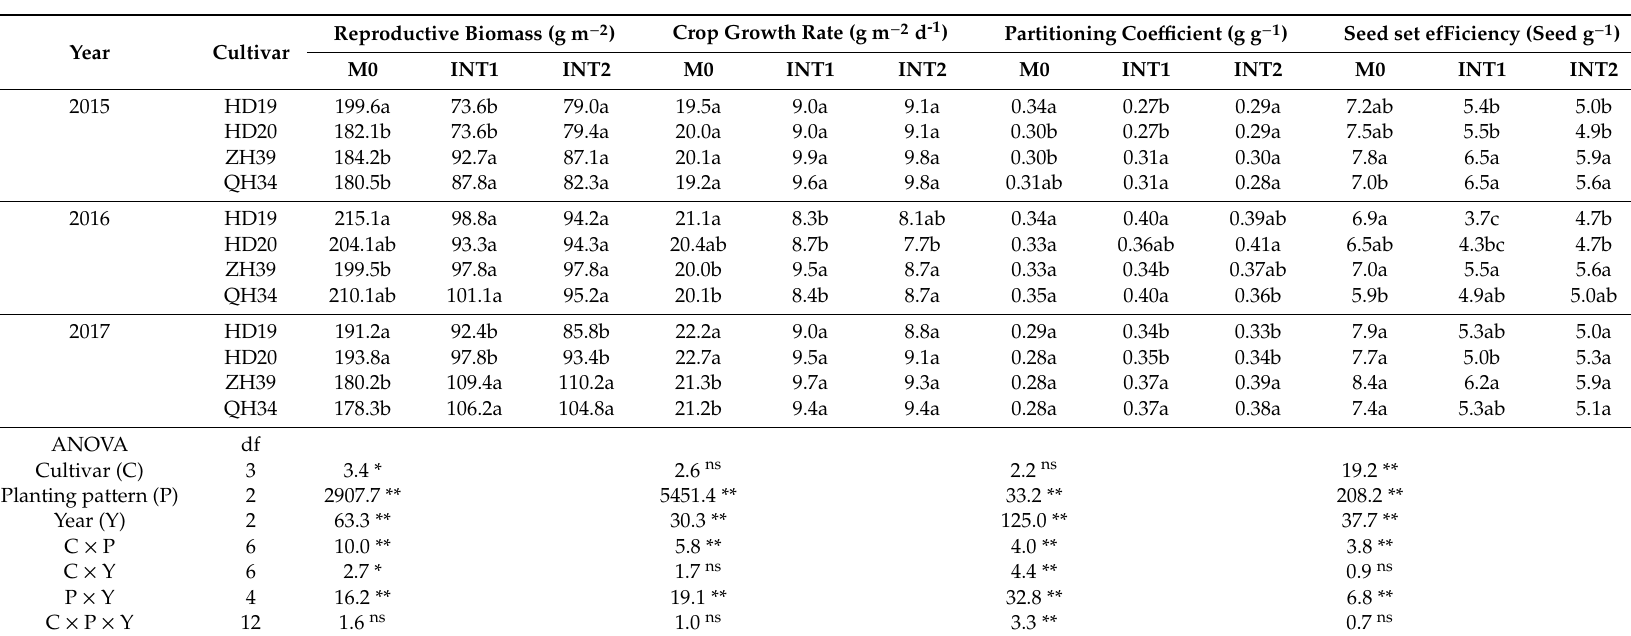
Table 4. Analysis of variance for seed number determinant parameters among soybean cultivars under di ff erent planting patterns during